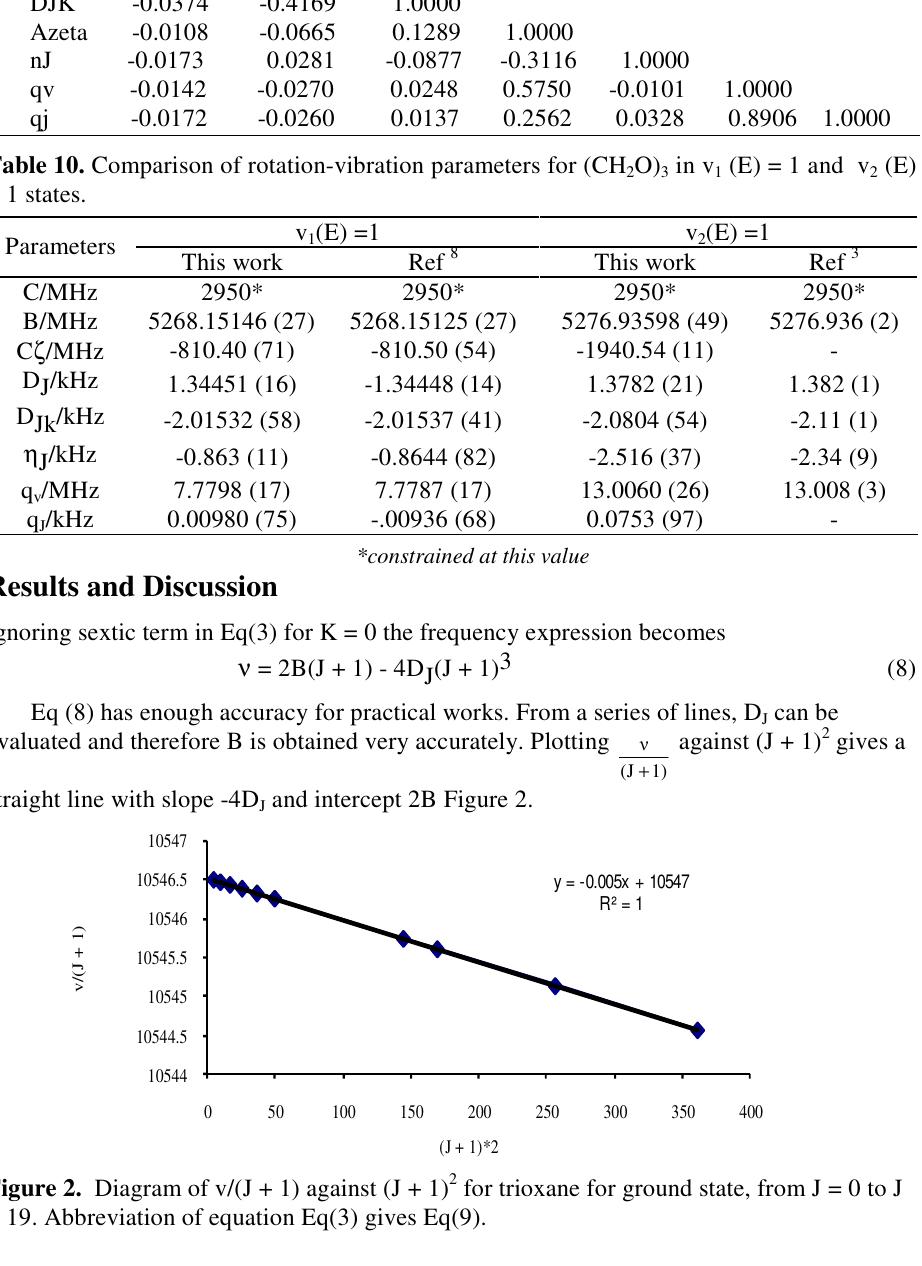
O) in v (E) = 1. 2 3 2